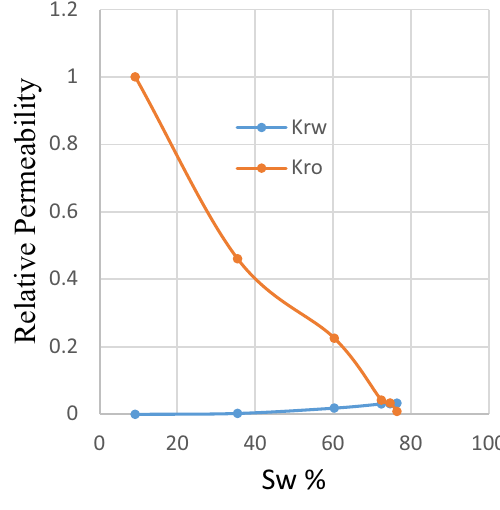
Fig. 9 Relative permeability of NHP-1